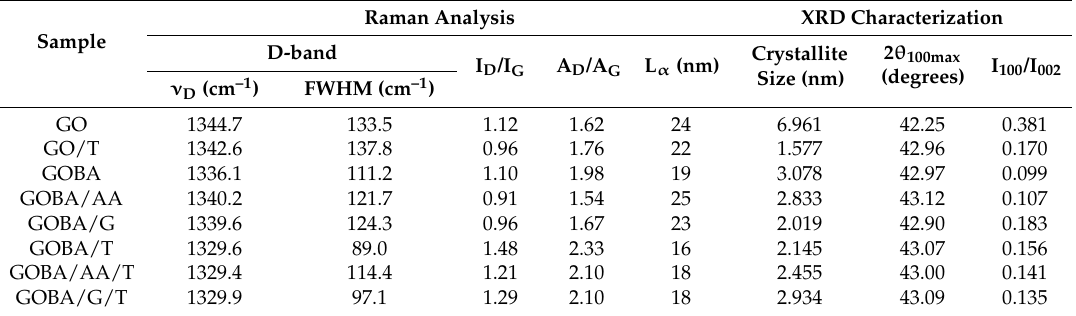
Table 1. The results of Raman and X-Ray diffraction (XRD) analysis for rGO samples and their precursors.